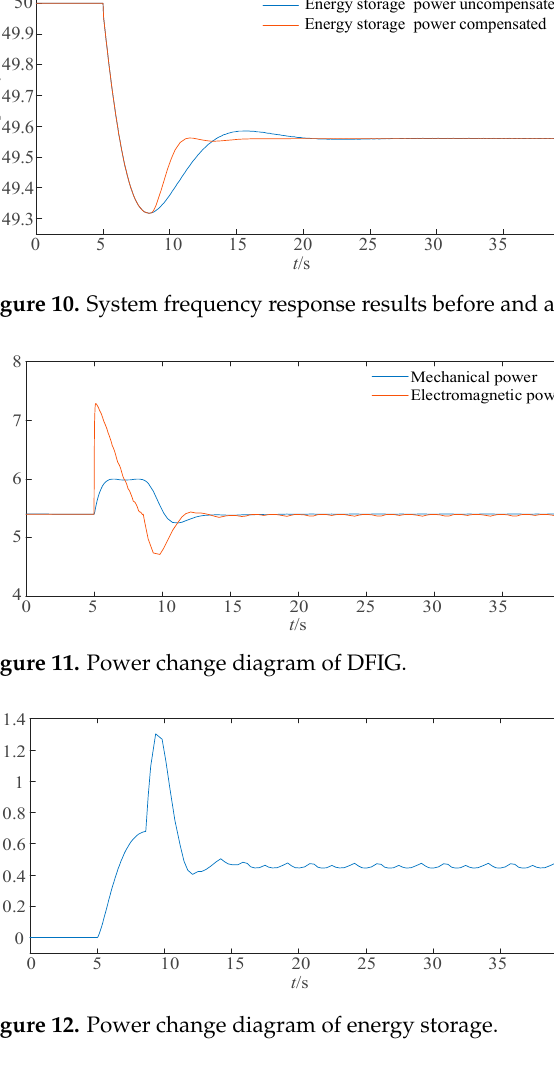
Figure 13. Variation diagram of rotor speed of DFIG. It can be seen from Figures 10–12 that the system frequency will enter the recovery phase after reaching the lowest point, and the DFIG will absorb energy from the system, which is not conducive to frequency recovery. The system frequency will be stable at 20 s. When the power is compensated by energy storage, the frequency stability time of the system is advanced to 15 s, the frequency fluctuation is reduced, and the recovery speed is improved. It can be seen from Figures 11 and 13 that when the DFIG is running in the overspeed mode, the speed of DFIG decreases and the mechanical power increases, which prevents the rotor speed from dropping sharply. At the same time, in the process of speed recovery, higher mechanical power also increases the acceleration torque of the rotor, provides en- ergy for the speed recovery, and reduces the energy absorbed from the system. 6. Conclusions In order to give full play to the frequency regulation potential of DFIG, energy stor- age, and controllable load in the microgrid, and improve the frequency stability of the system, this paper proposes a hierarchical cooperative frequency regulation control strat- egy of wind-storage-load in a microgrid based on model prediction. Through theoretical and simulation analyses, the conclusions are as follows: 1.